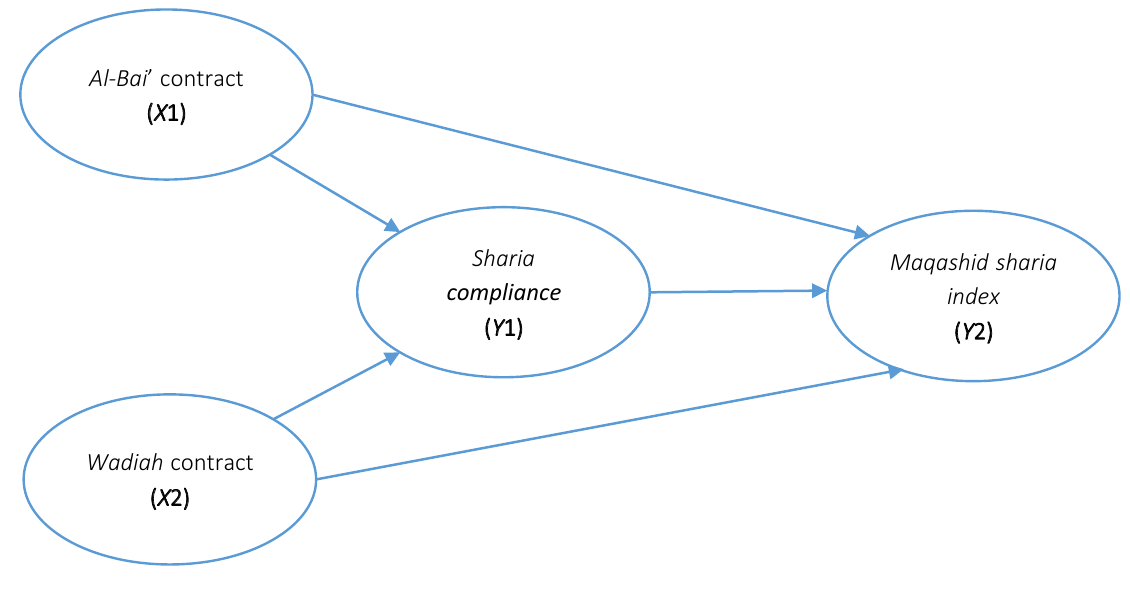
Figure 1. The conceptual